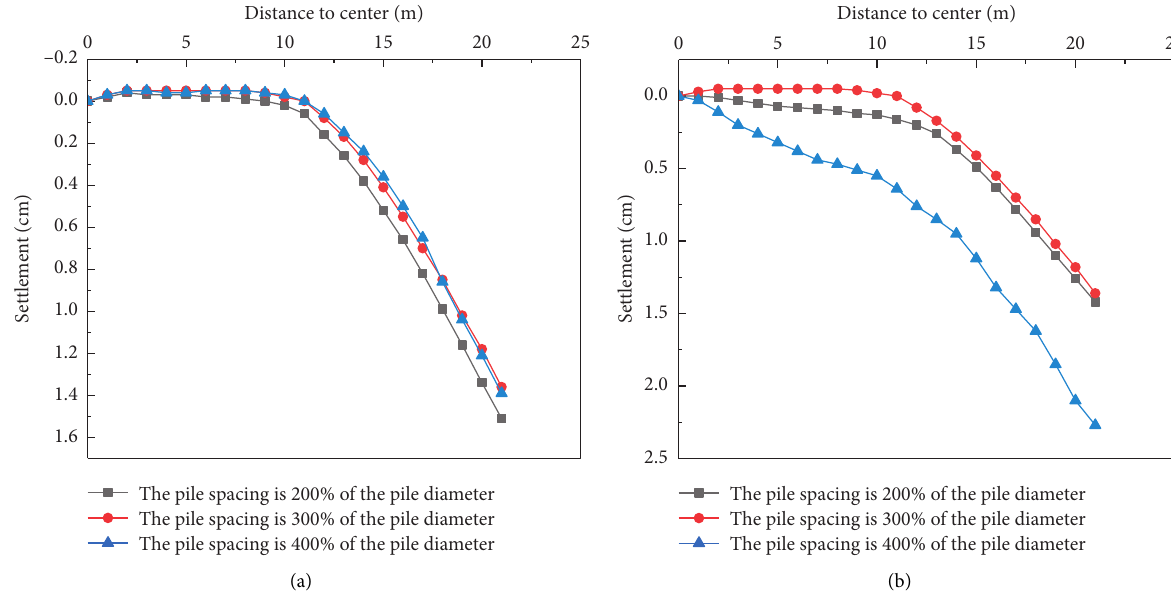
Figure 7: Postconstruction differential settlement diagram of the subgrade surface under different piles spacings. (a) Varying the pile spacing under the existing road slope. (b) Varying the pile spacing under the existing subgrade and new